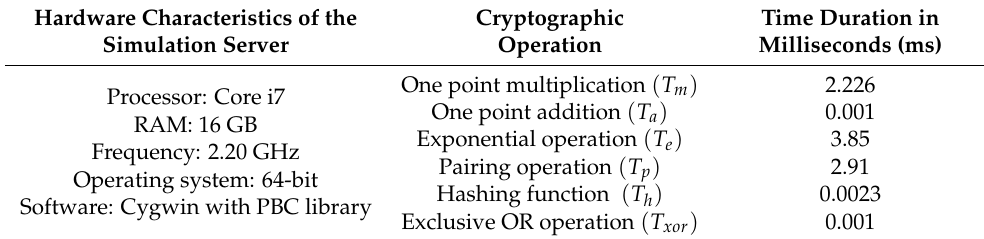
Table 1. Time duration for cryptographic operations.